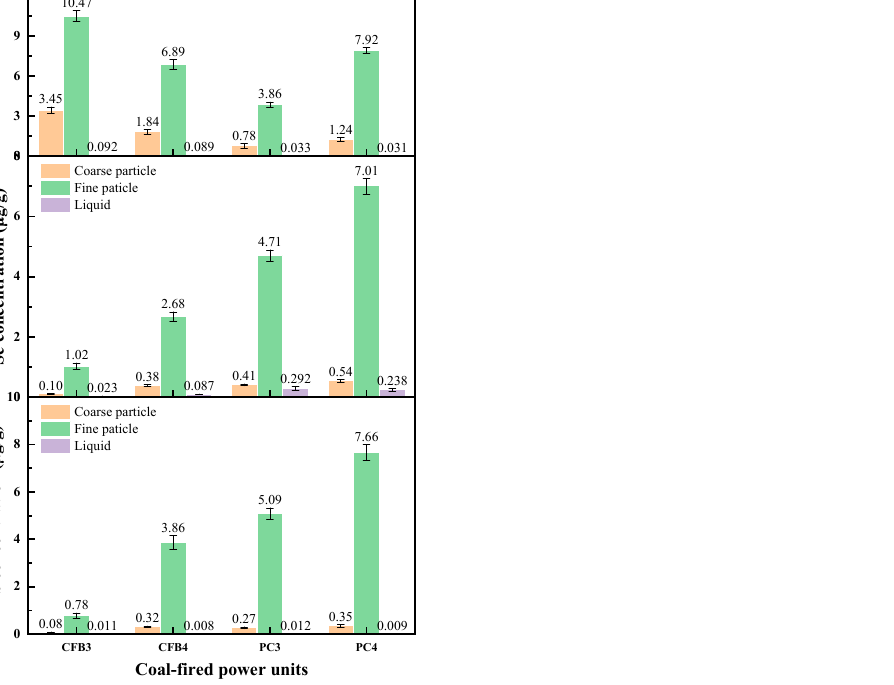
Figure 4. Concentrations of As, Se and Pb in coarse particles, fine particles and liquid fraction of WFGD slurry.